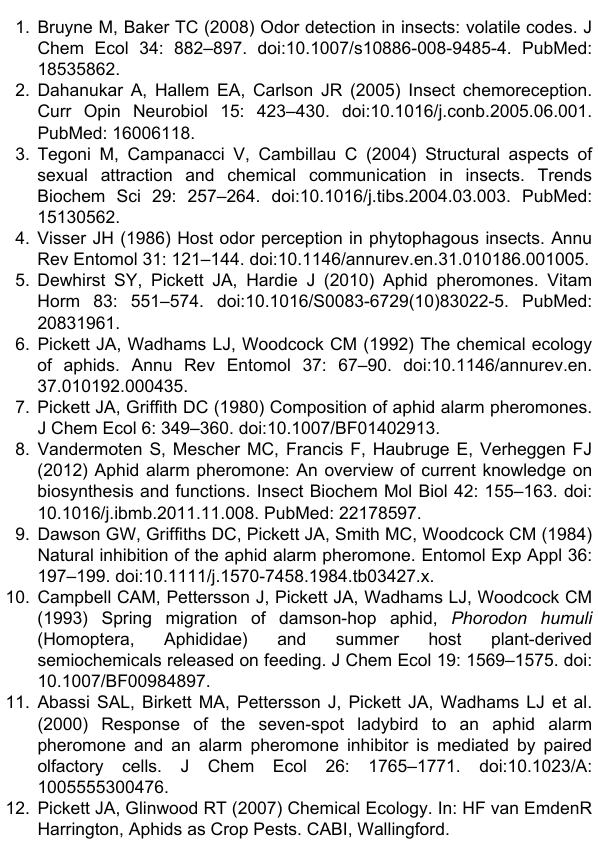
Table S3. A percent identity matrix of A. gossypii OBPs.